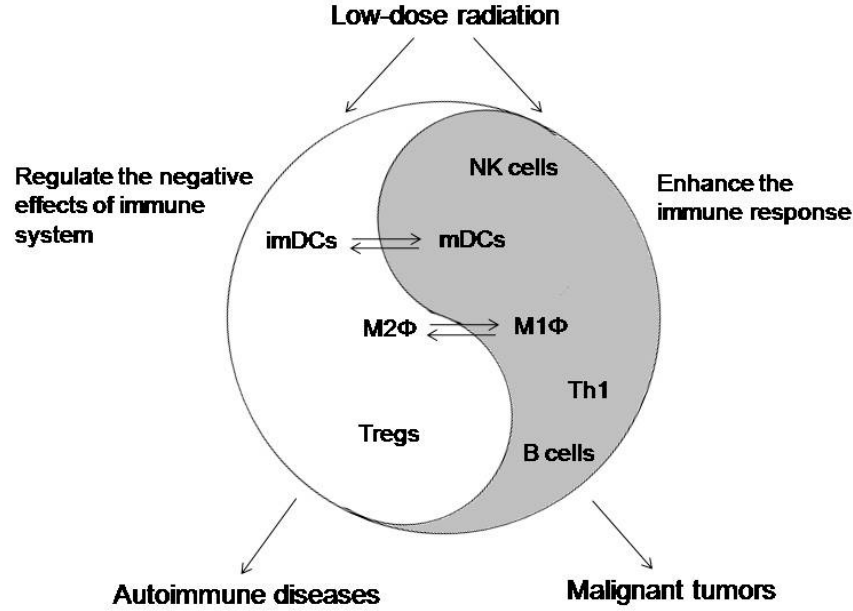
Figure 1. A model of LDR-induced hormetic effects on the immune system and their clinical indication. LDR has been shown to have dual effects on the regulation of immune hormesis. On the one hand, LDR could enhance the cytotoxicity of natural killer (NK) cells, promote the differentiation of mature dendritic cells (mDCs) and M1 macrophages (M1 Φ ), and activate T helper type 1 (Th1) cells and B cells (gray part of the figure), leading to the enhancement of the immune response, which can be applied in the treatment of malignant tumors. On the other hand, LDR regulates negative effects of the immune response by inhibiting the transformation of immature DCs (imDCs) to mDCs, inducing the differentiation of M2 Φ , and stimulating a retention/expansion of Tregs (white part of the figure). This immunosuppressive activity can be used to control autoimmune diseases.